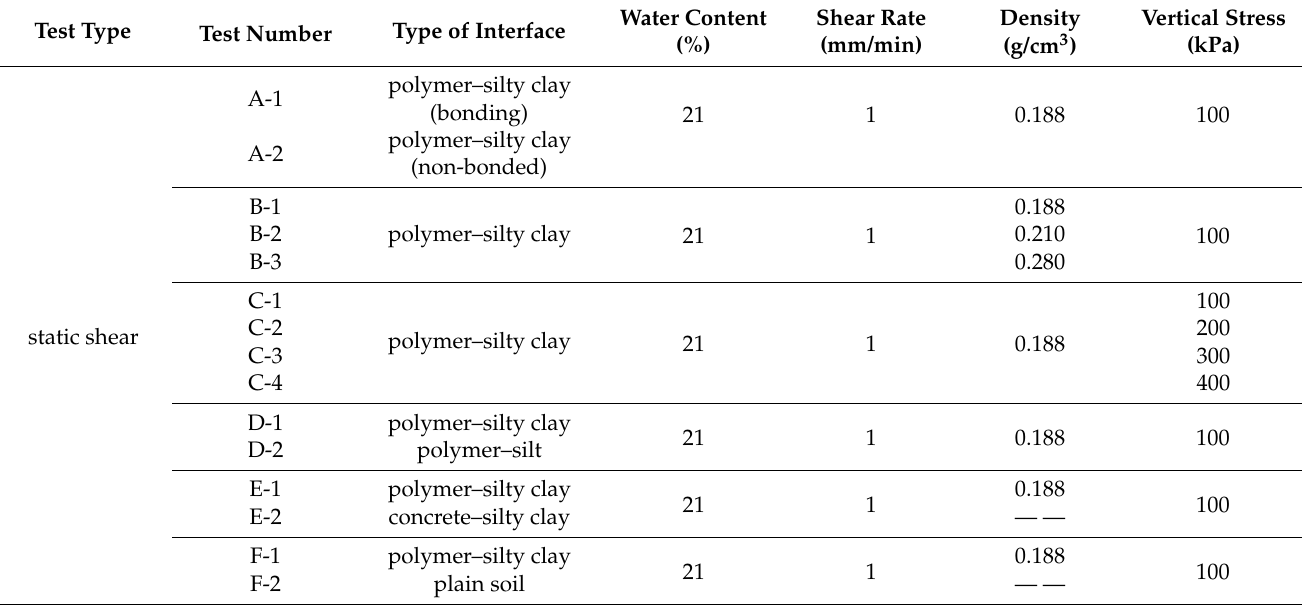
Table 4. Static shear test schemes of polymer–soil interface.